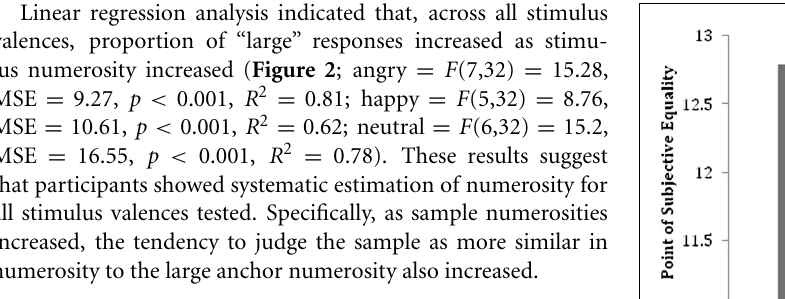
FIGURE 1 | Example of a trial within the numerical bisection training task. A participant begins a trial by fixating on a cross.The participant is then shown a stimulus screen, displaying a number of stimuli to rapidly